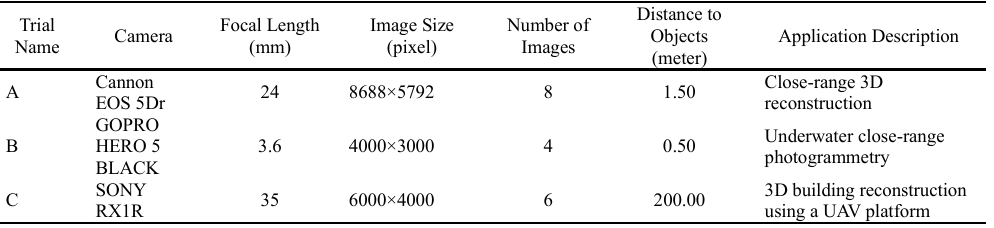
Table 1. Camera information and image parameters of three trials